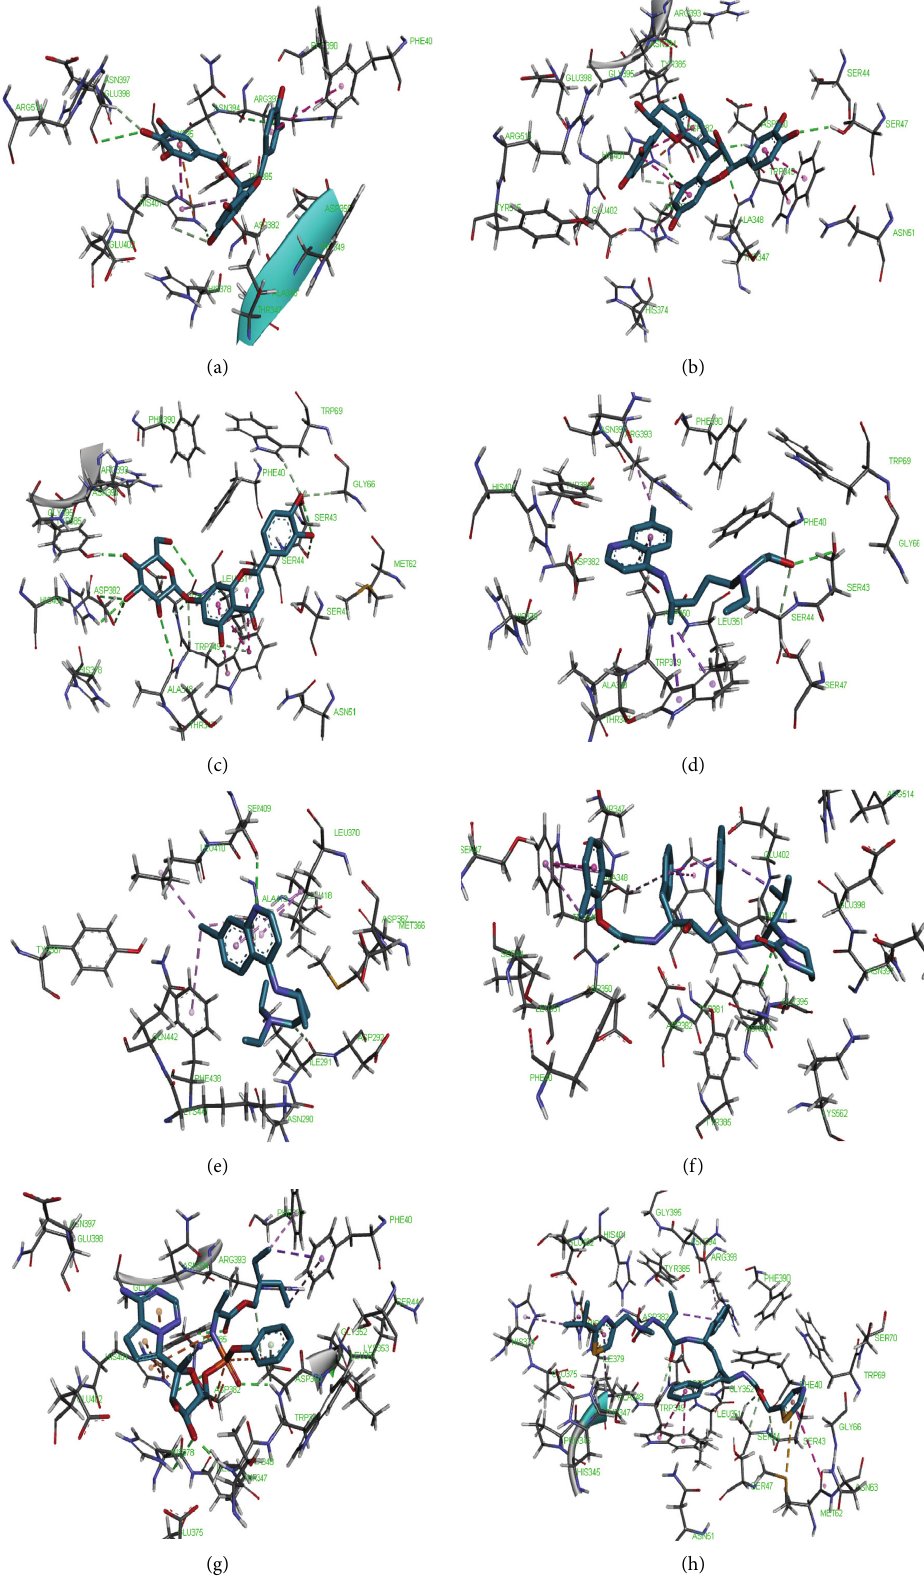
Figure 14: 3D representation of (a) 3-galloylcatechin, (b) proanthocyanidin B1, (c) luteolin 7-galactoside, (d) chloroquine, (e) hydroxychloroquine, (f) lopinavir, (g) remdesivir, and (h) ritonavir in the binding pocket of